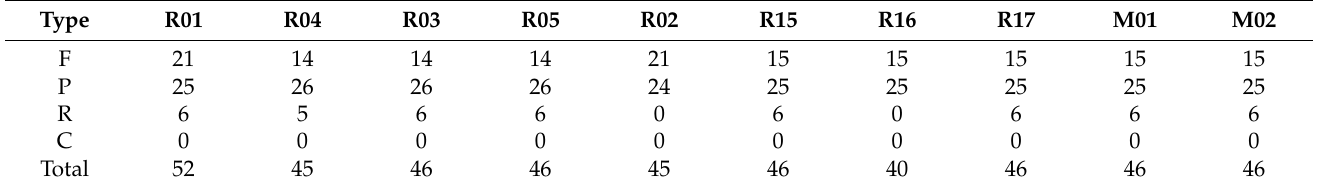
Table 3. Types and number of repeat sequence in the chloroplast genomes of Prunus mume